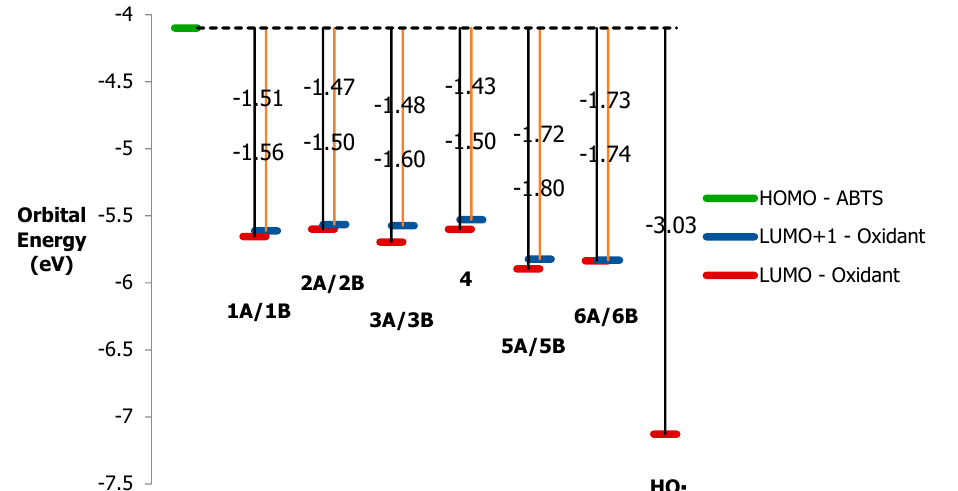
Figure 8. Energy di ff erence between HOMO of ABTS and the LUMO and LUMO + 1 of [(L)Ni 3 + -O · ] 2 +